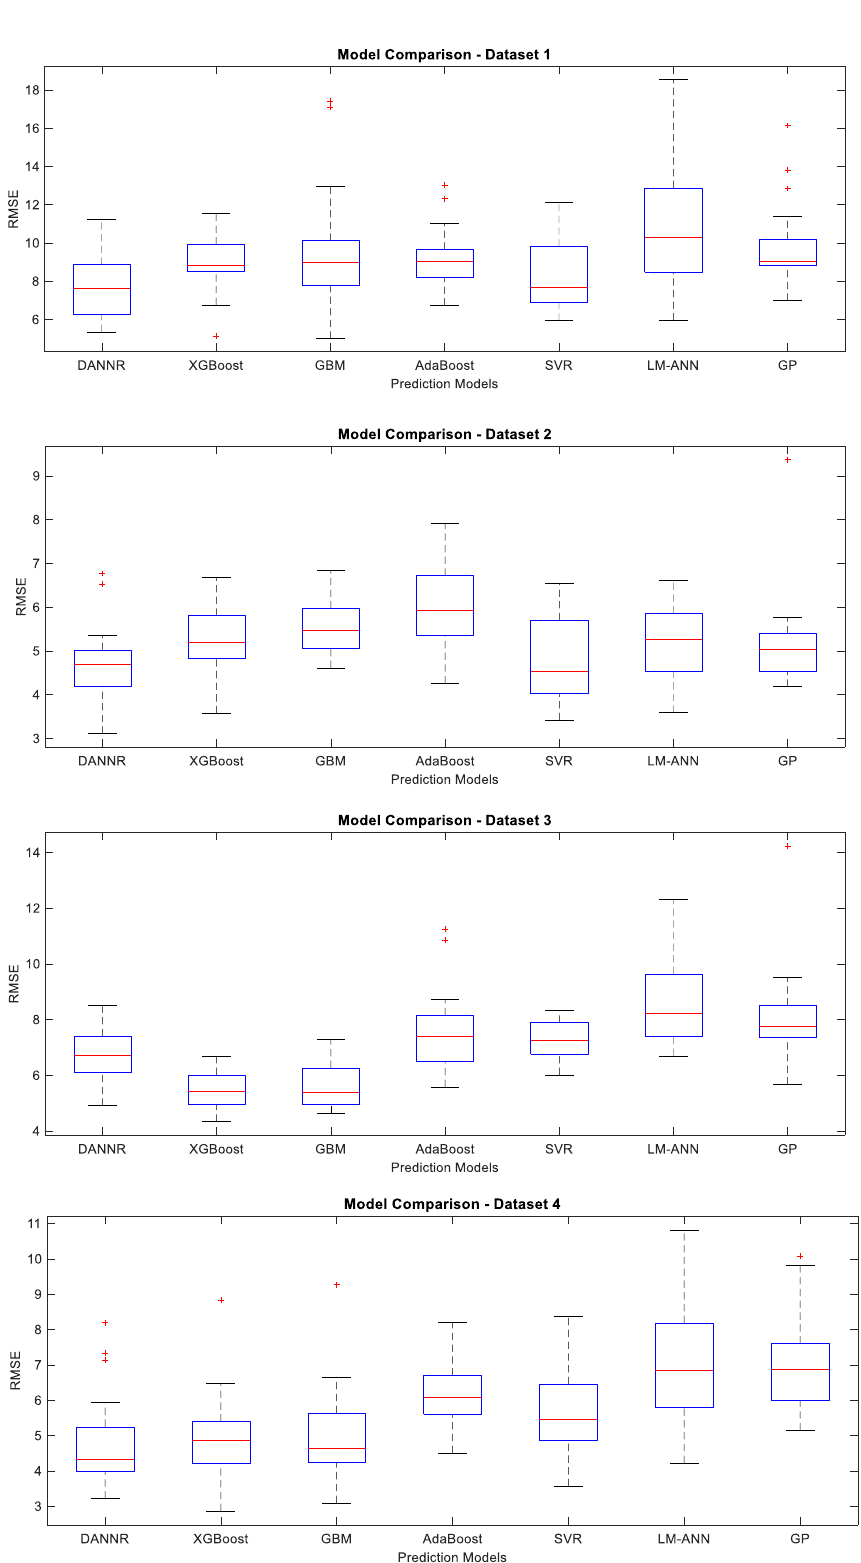
Figure A1. Boxplots of the model performance (The blue box denotes the 25th and 75th percentiles of RMSE. The red line represents the median value. The symbol “+” denotes an outlier.)